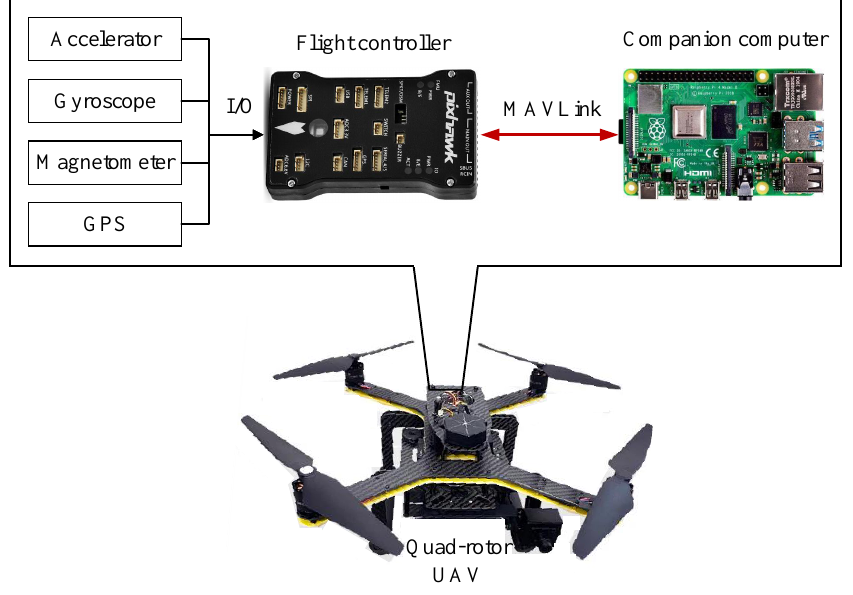
Figure 4. The structure of our UAV